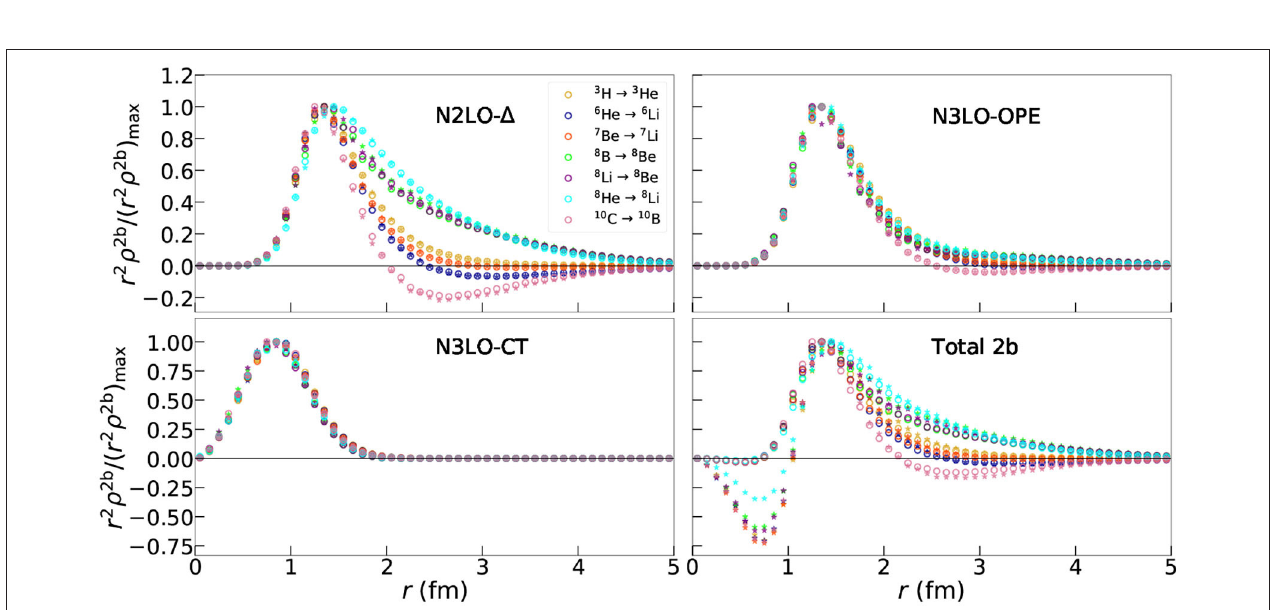
FIGURE 5 | Scaled two-body density as defined in Equation (13) for GT RMEs obtained using the NV2+3-Ia/Ia* models for select nuclei. The distributions are scaled to have a peak value of 1.0 using the factors in Table 3 .